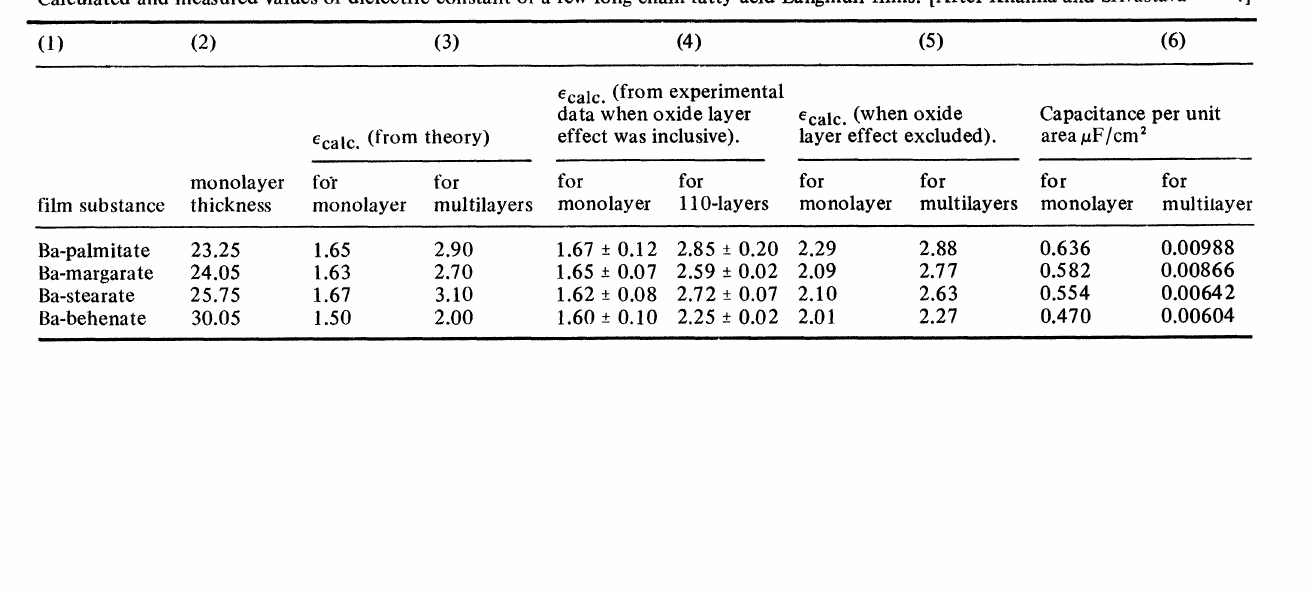
TABLE II Calculated and measured values of dielectric constant of a few long chain fatty acid Langmuir films. [After Khanna and Srivastava